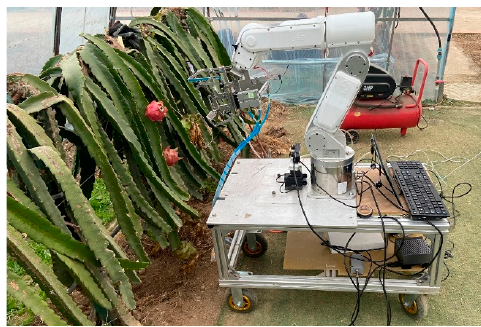
Figure 9. Dragon fruit picking experiment scene in orchard.